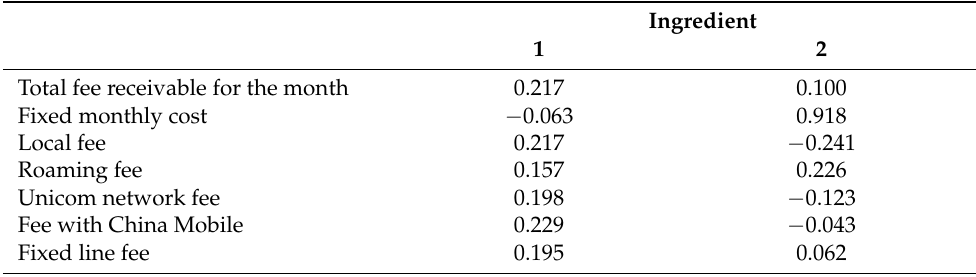
Table 8. Component score coefficient matrix.